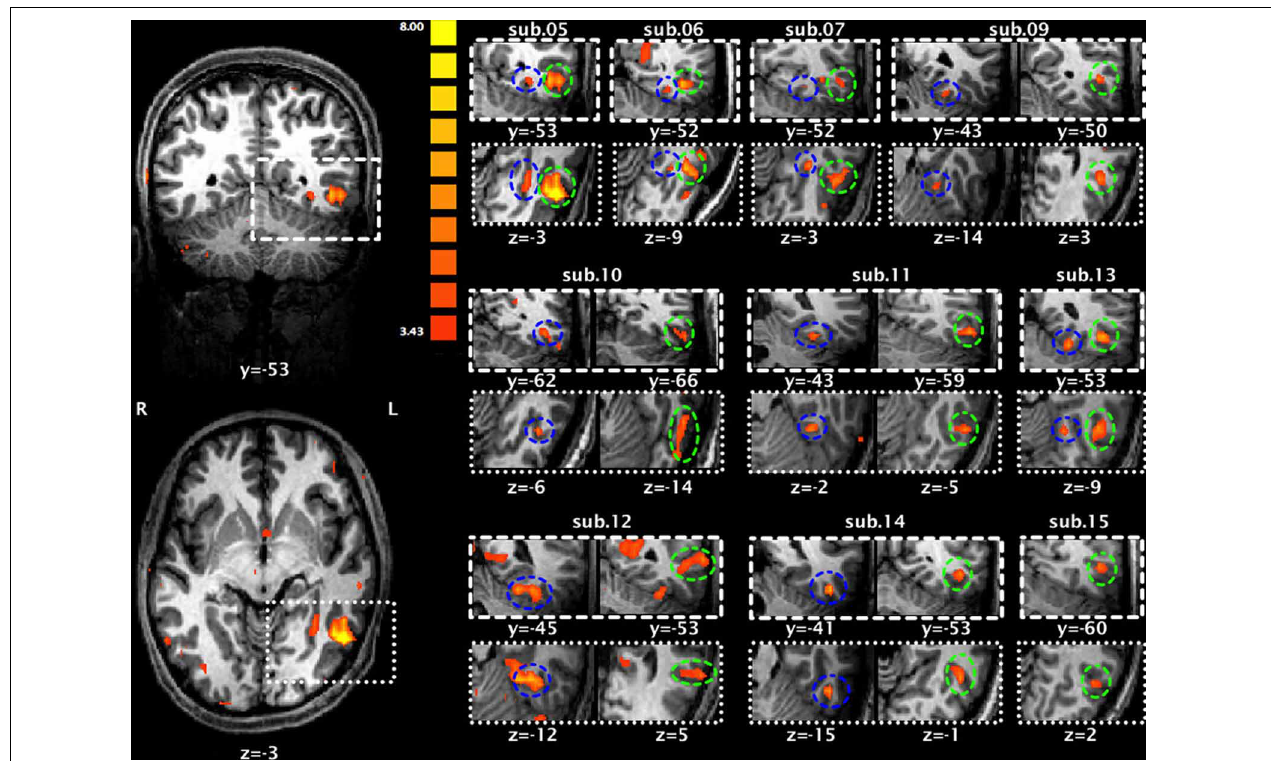
FIGURE 3 | Significant activation of the left occipitotemopal cortex for each subject during localizer runs for Chinese characters compared to faces. The two activation maps on the left (upper: coronal view; lower: horizontal view) are from subject 5. Maps on